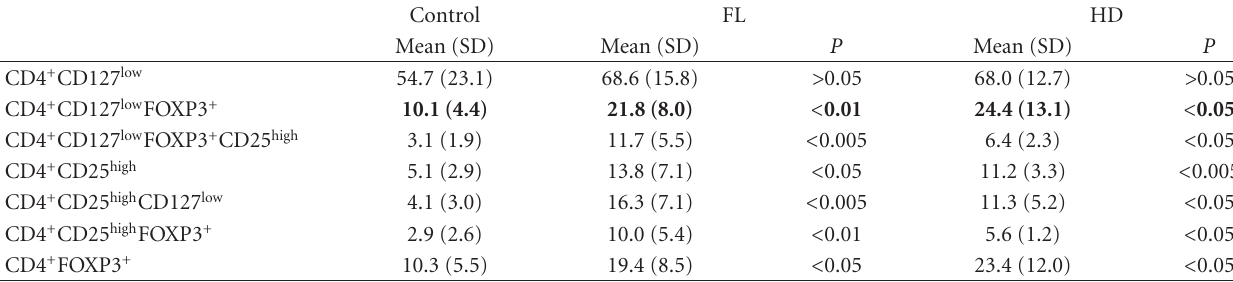
Table 4: Assessment of T reg -cell frequencies in lymph node biopsies.